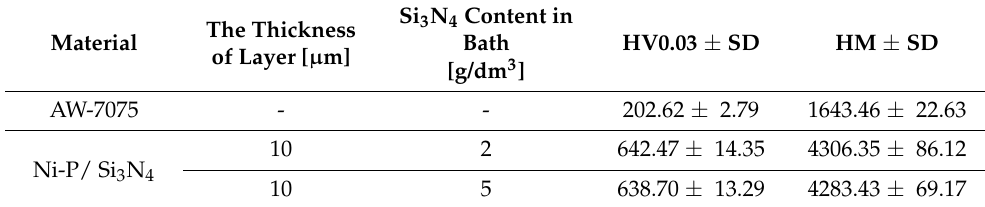
Table 6. The coatings